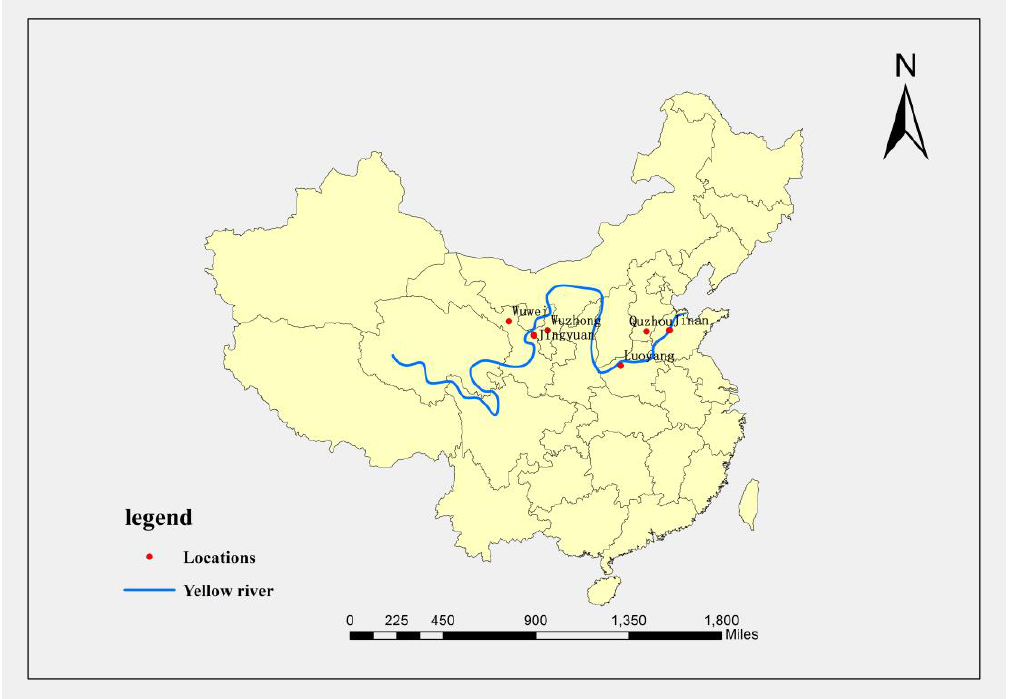
Figure 1. The locations where the experiments were conducted in 6 cities/counties along the Yellow River basin of China.